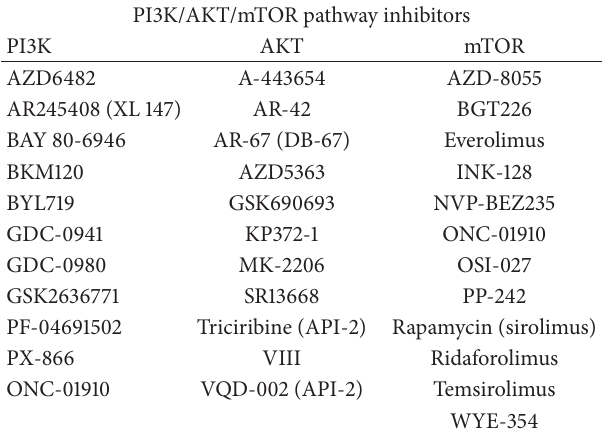
Table 2: Table of PI3K, AKT, and mTOR inhibitors in development